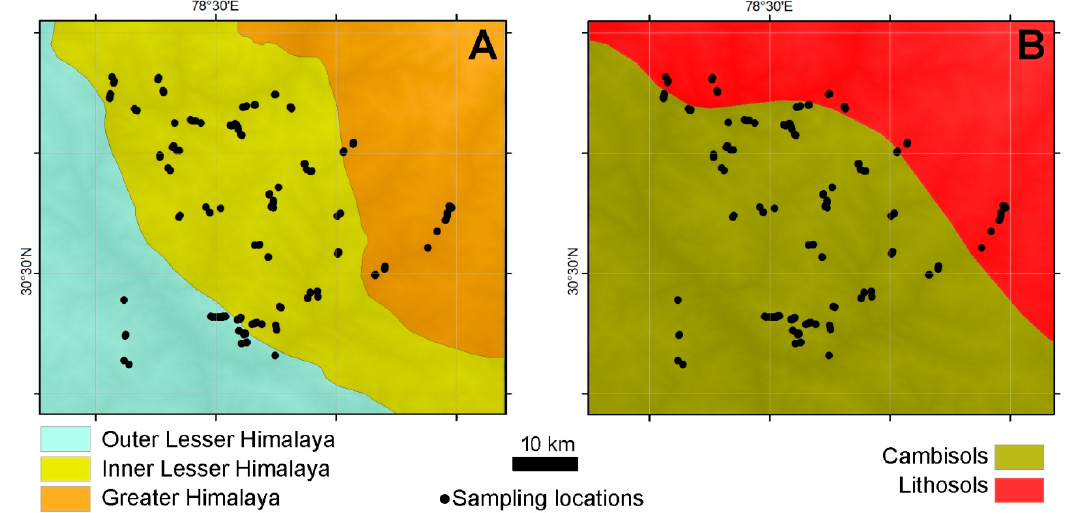
Figure 2. ( A ) Simplified geological (based on Mukherjee [76–79]) and ( B ) soil sketch of the studied area, based on FAO-UNESCO [74–79].